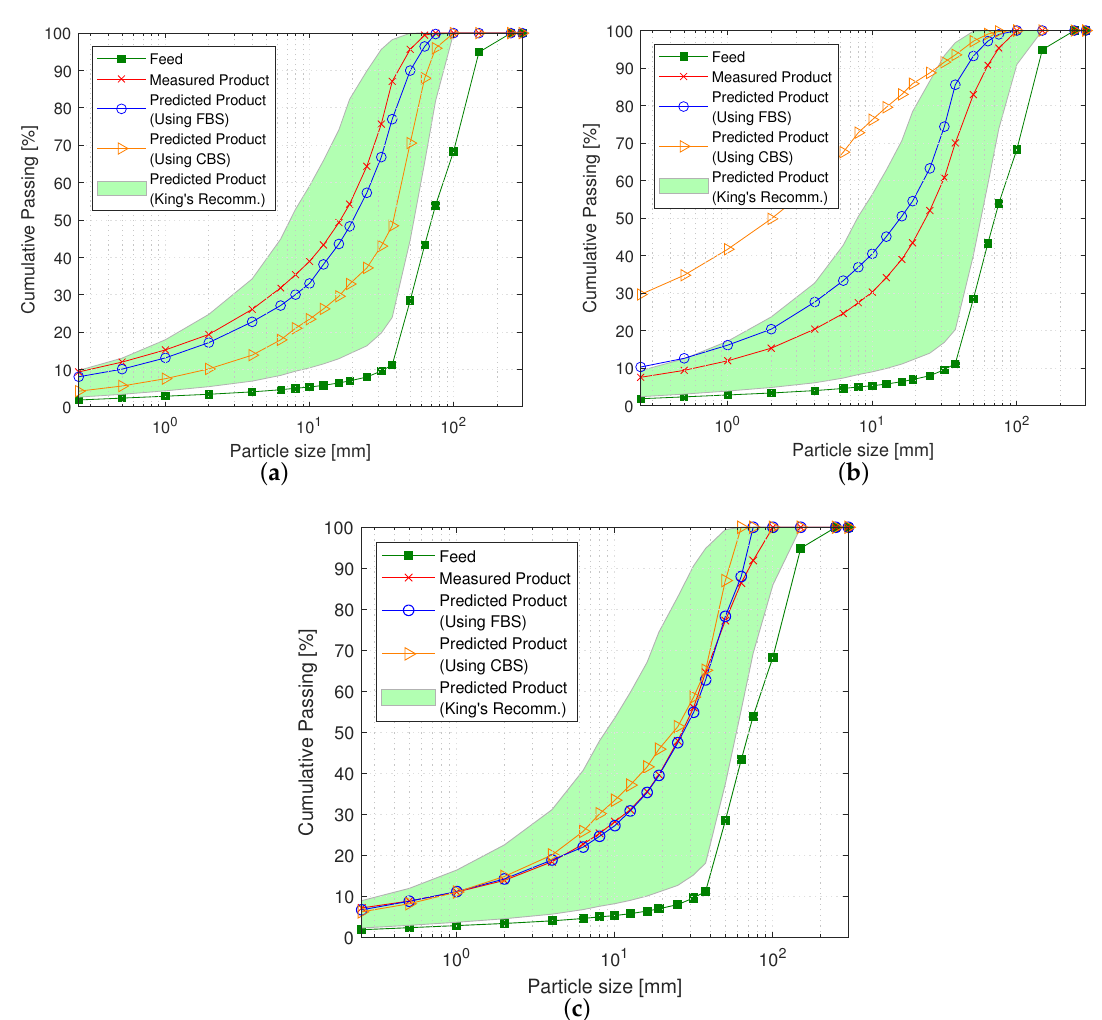
Figure 7. Measured and predicted PSD curves in Scenario 2 for the Serra Leste datasets. ( a ) PSD predicted using the model calibrated on datasets 2 and 3. Validation with Dataset 1. ( b ) PSD predicted using the model calibrated on datasets 1 and 3. Validation with Dataset 2. ( c ) PSD predicted using the model calibrated on datasets 1 and 2. Validation with Dataset